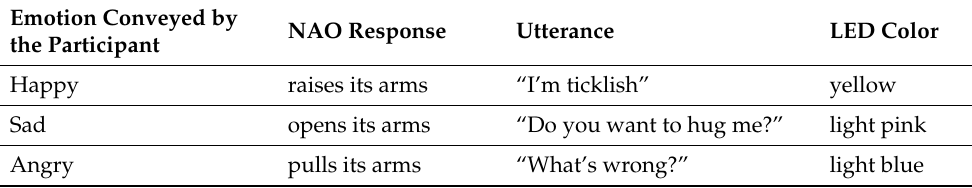
Table 3. Responses of NAO to emotions conveyed through participant’s social